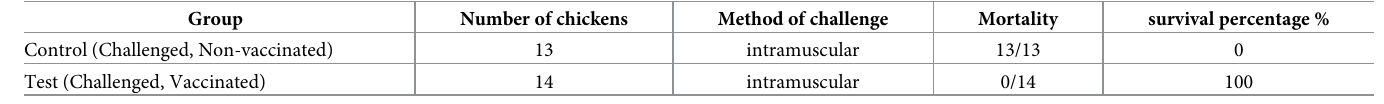
Table 8. Summary of challenge trial conducted to test vaccine efficary agaisnt Genotype VII.2.